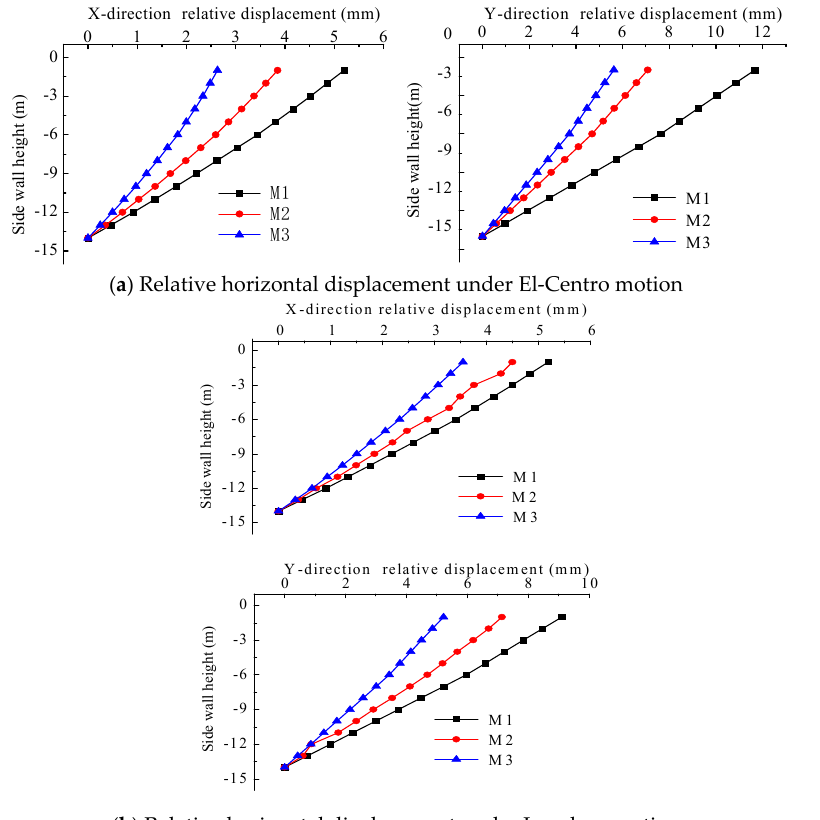
Figure 19. Relative horizontal displacement of the side wall.